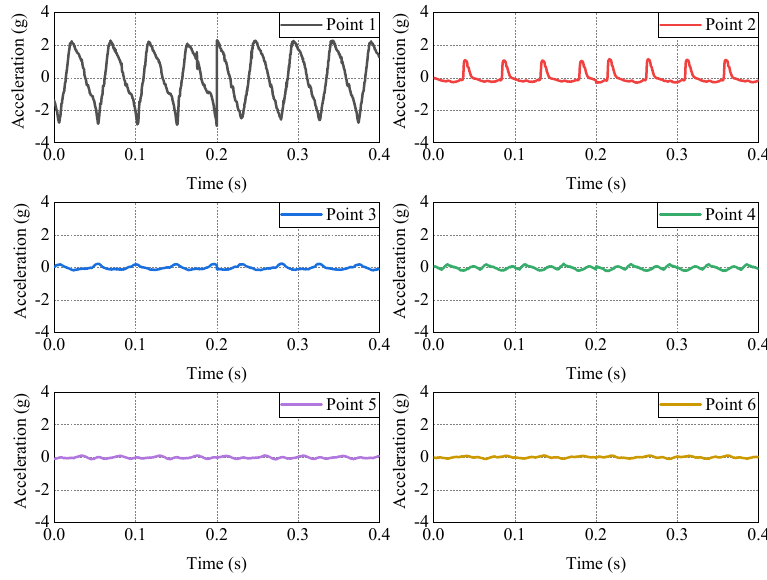
Figure 6. The time − history curve of each measuring point.